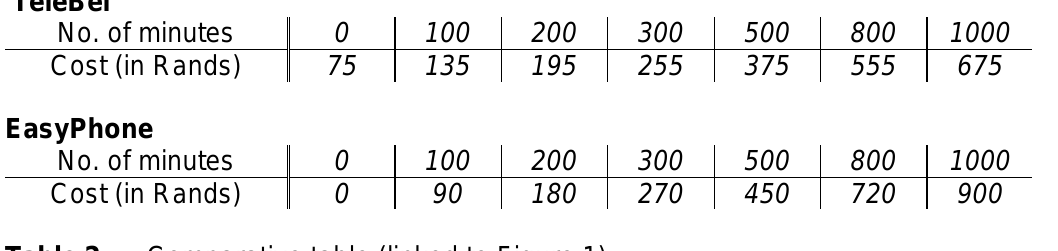
Comparative table (linked to Figure 1)